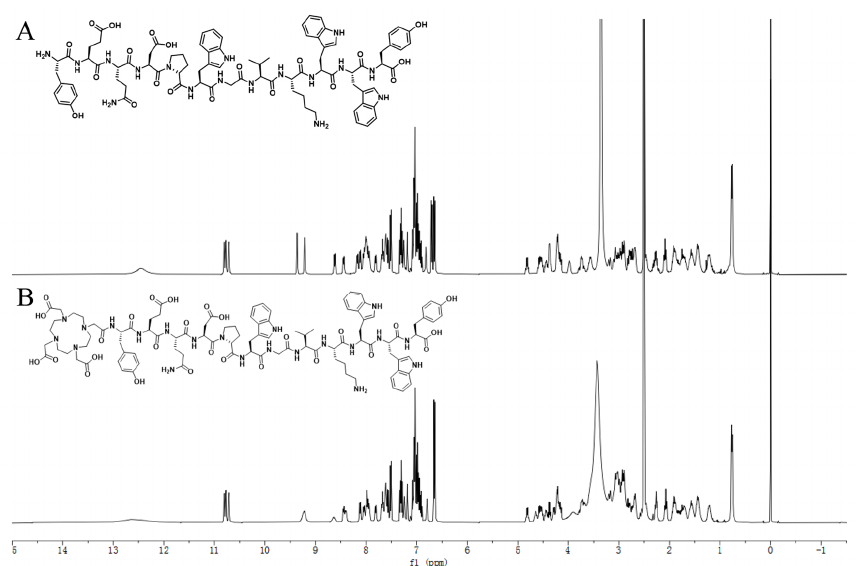
Figure A1. 1 H NMR spectrum of M2pep ( A ) and DOTA-M2pep ( B ) in DMSO. ∆ = 6.5~8.5 ppm